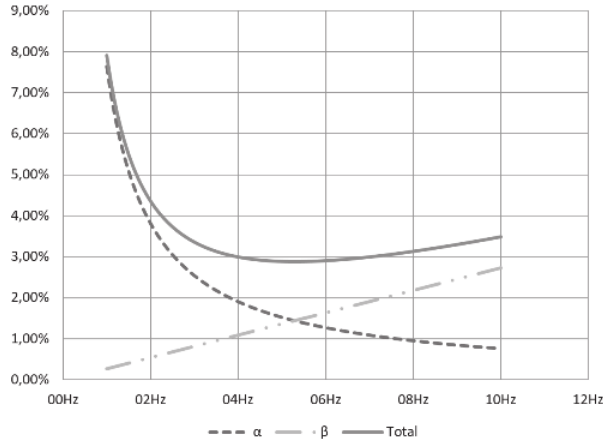
Amortecimento de Rayleigh